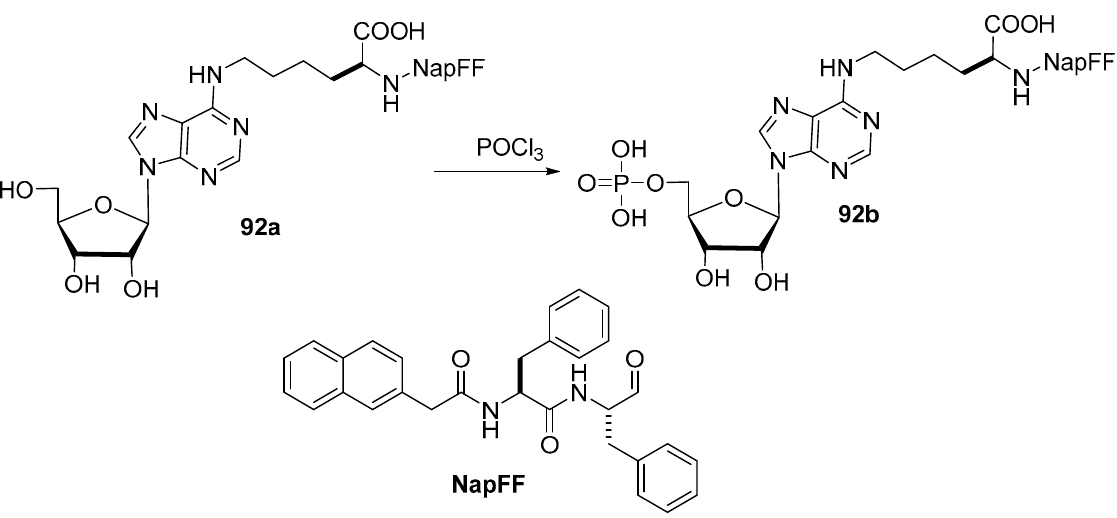
Figure 54. Synthetic route for the adenosine monophosphate-based gelator [102].